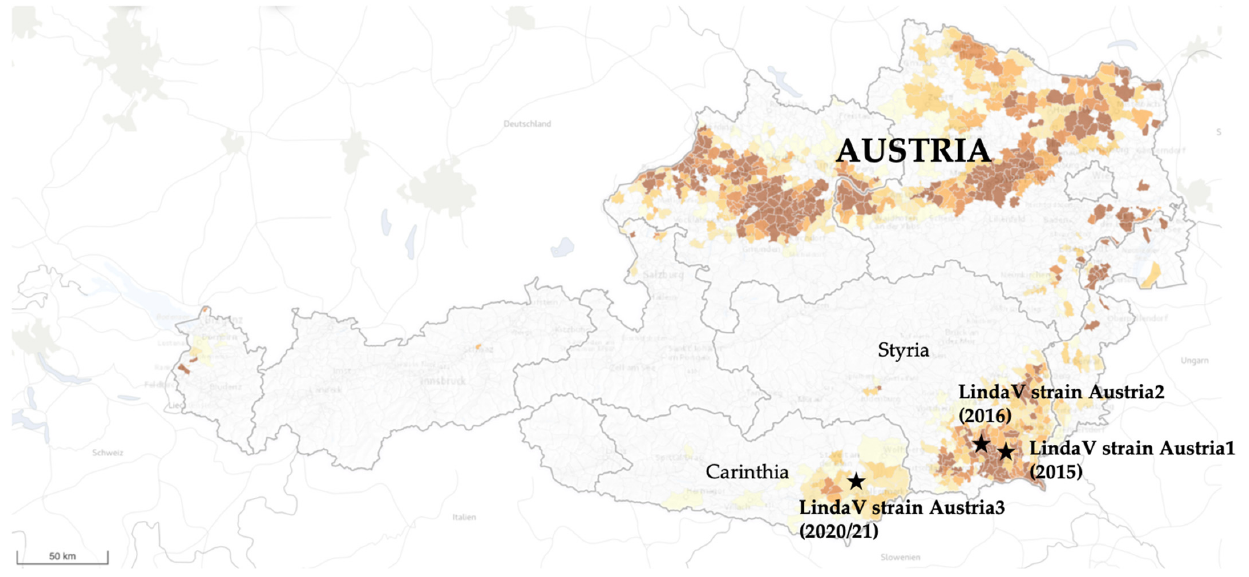
Figure 1. Locations of the farms where Linda virus (LindaV) strains Austria1, Austria2, and the novel strain Austria3 were isolated. Stars indicate the locations of the farms. Different brown shades mark regions with a high (dark brown) and a low (light brown) pig density. LindaV: Linda virus. (Modified from: https://www.statistik.at/atlas/?mapid=them_lw_as2010_viehbetriebe&layerid=layer1&sublayerid= sublayer0&languageid=0 (accessed on 18 August 2021). © Statistics Austria—Cartography and GIS, created 1 September 2018).